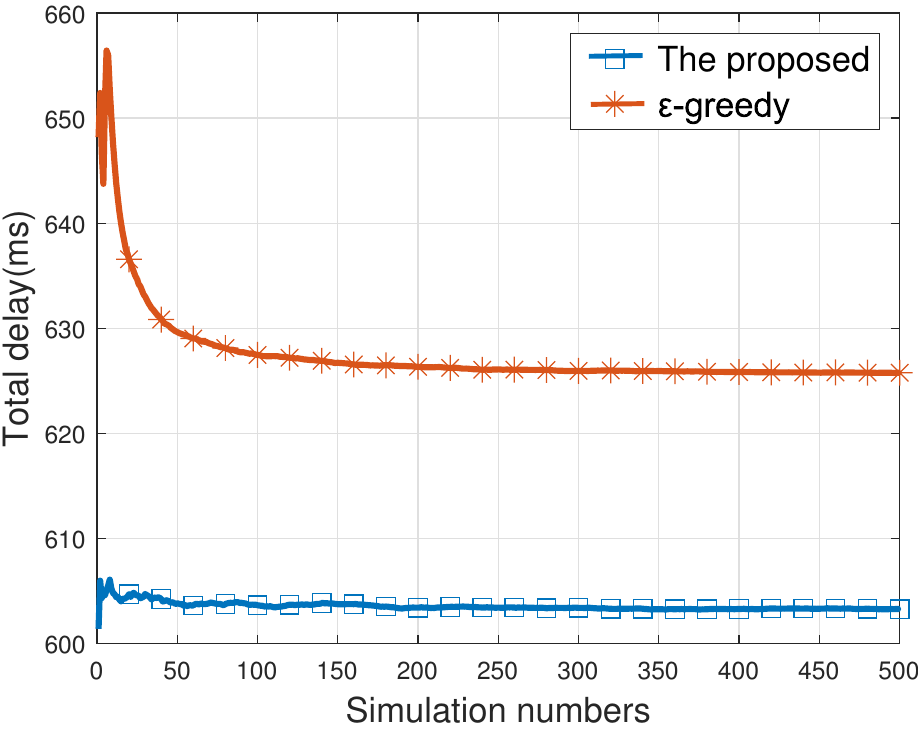
Figure 12. Total delay versus simulation